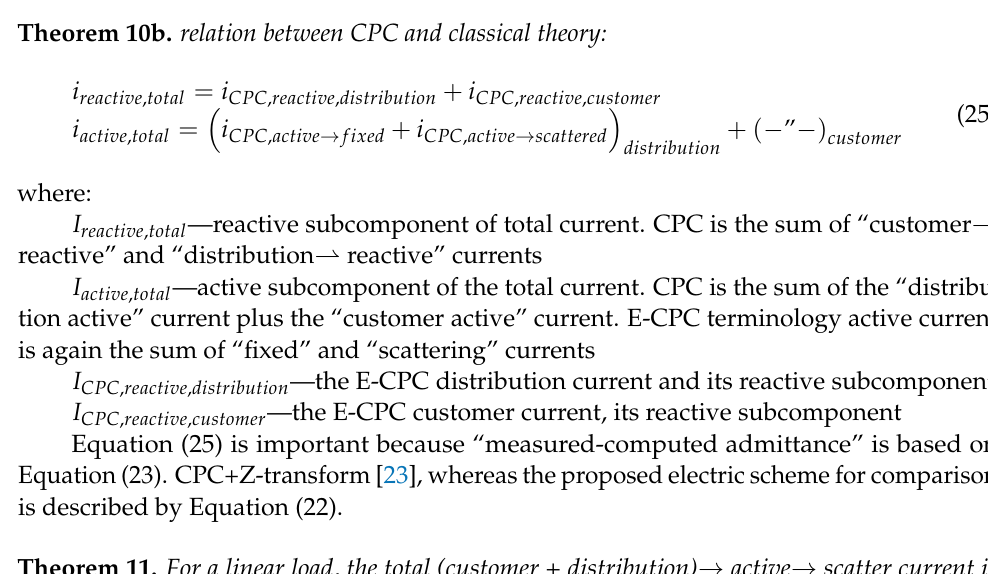
Figure 9. Schematic illustration of E-CPC enabling grid scheme extraction by the provision of multiple equations through harmonics. Demonstration of Theorem